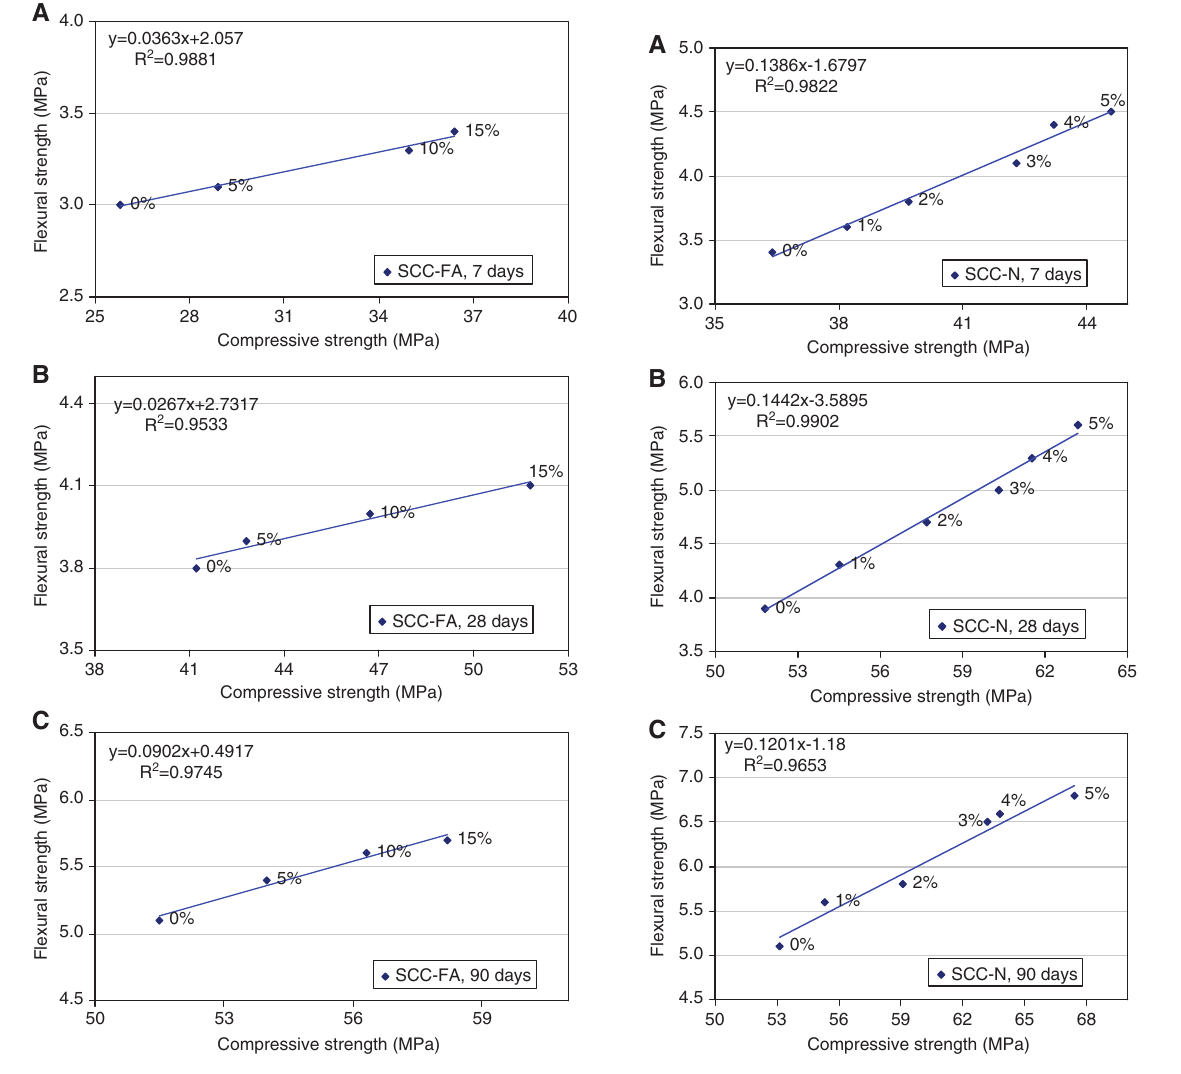
Figure 2 Relationship between flexural and compressive strength of SCC-FA mixtures for (A) 7 days, (B) 28 days, and (C) 90 days of curing.